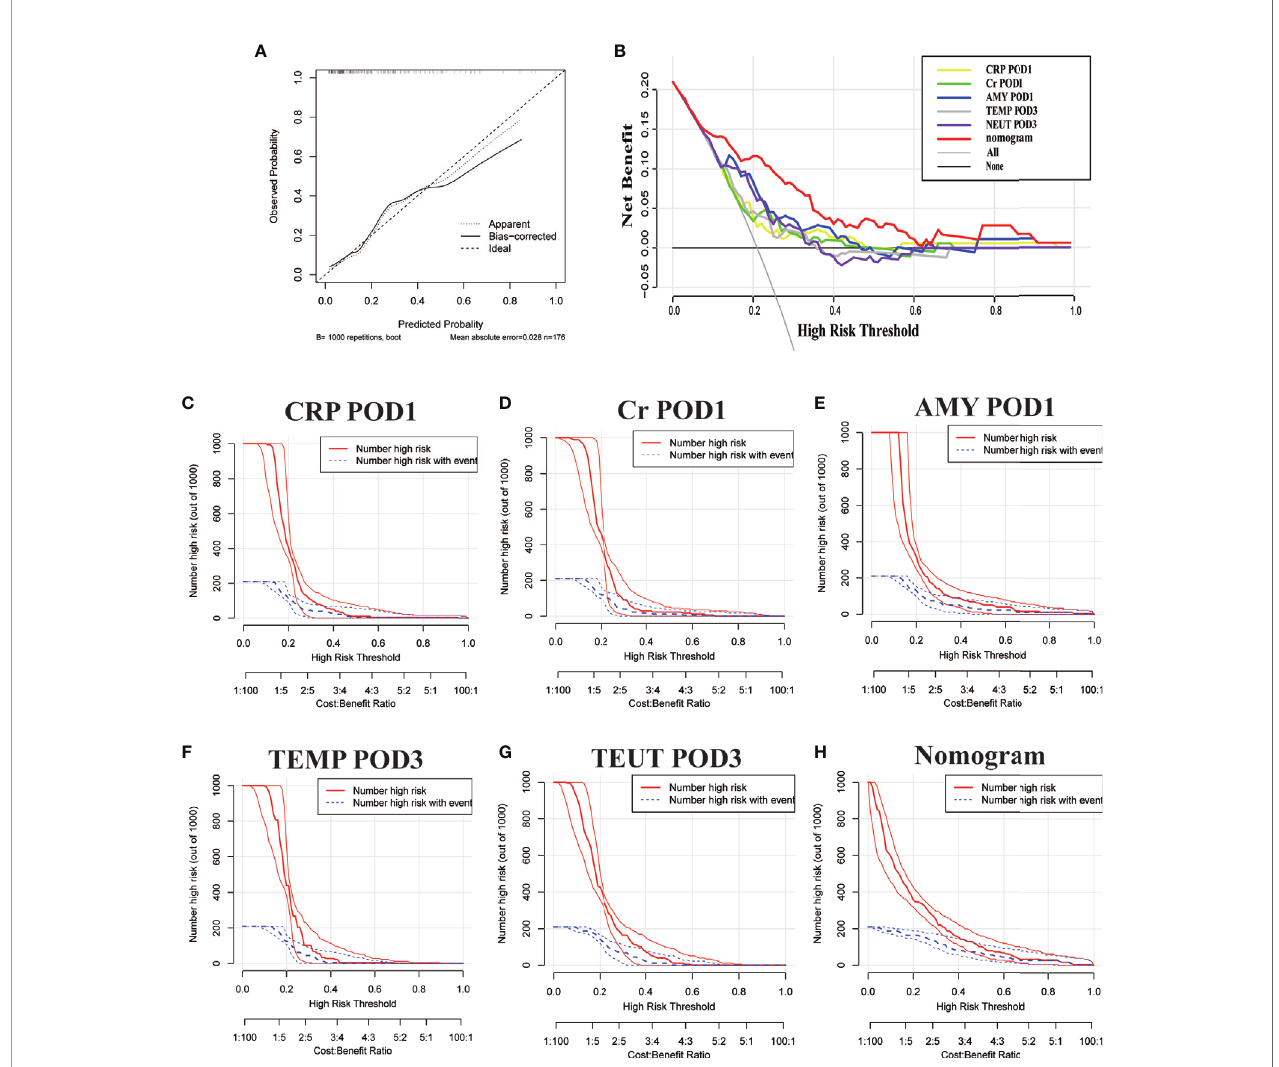
FIGURE 3 | The calibration curves (A) , decision curve analysis (B) , and a clinical impact curve (C – H) of the nomogram and risk